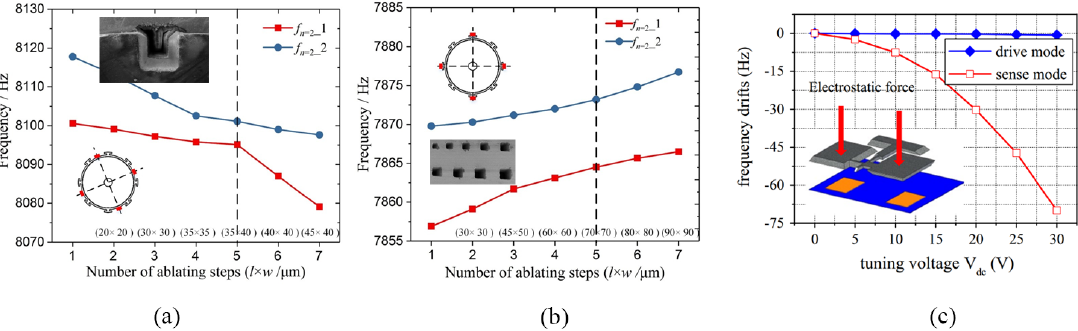
Figure 4. ( a , b ) When the laser ablation grooves are properly designed, the resonant frequency can be raised or lowered as desired [81]; ( c ) The change of the resonant frequency caused by the electro- static force